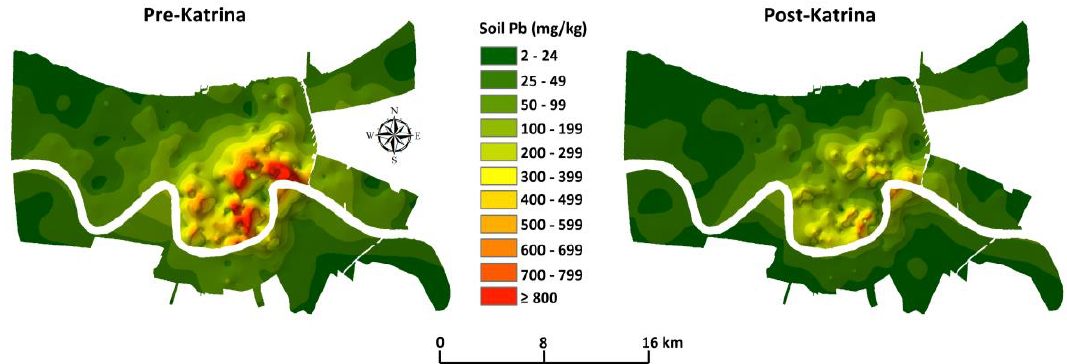
Figure 2. Pre- and post-Hurricane soil lead map by medians for 285 census tracts of New Orleans. Note the legend showing the shift from dark red, higher soil lead in pre-Katrina to orange and yellow colors representing substantially lower soil lead in post-Katrina New Orleans.